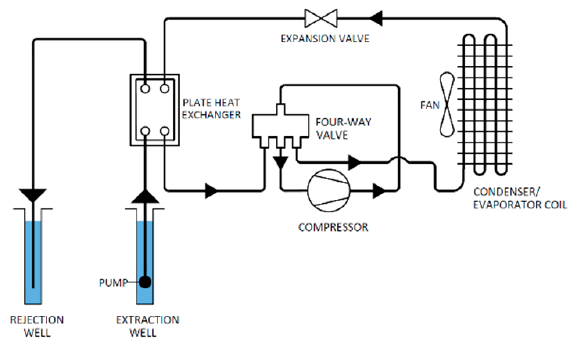
Figure 8. The schematic of the groundwater heat pump in heating mode.